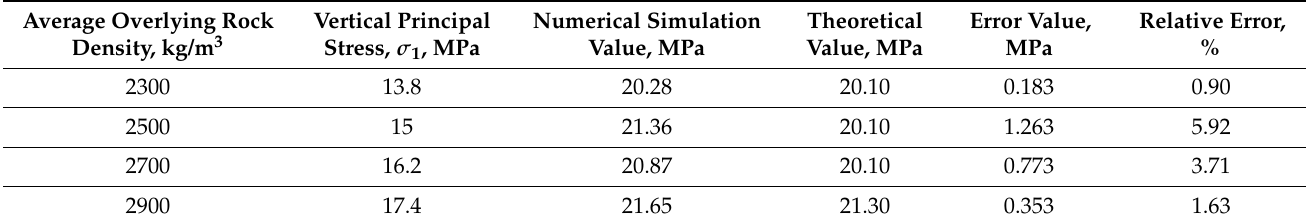
Table 3. Comparison of grouting pressure under different overlying rock densities.